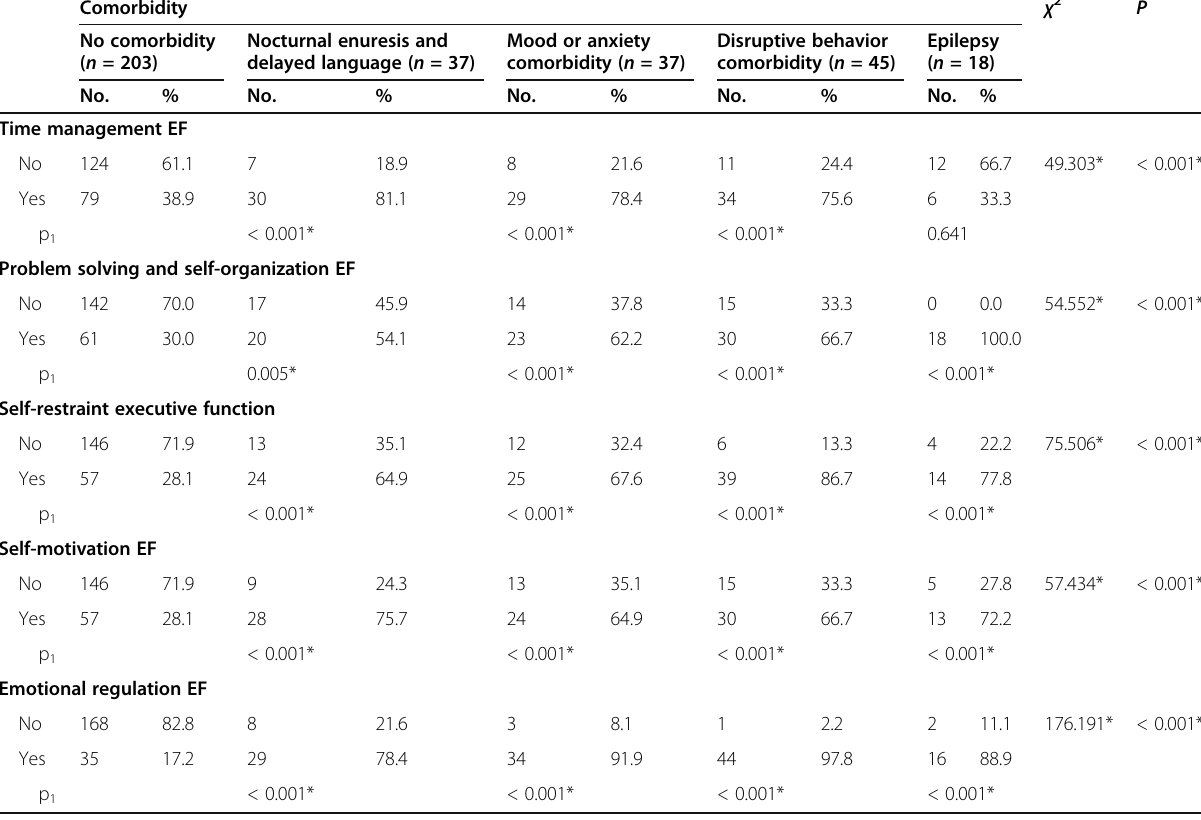
Table 3 Relation between other comorbidities and executive function among the studied